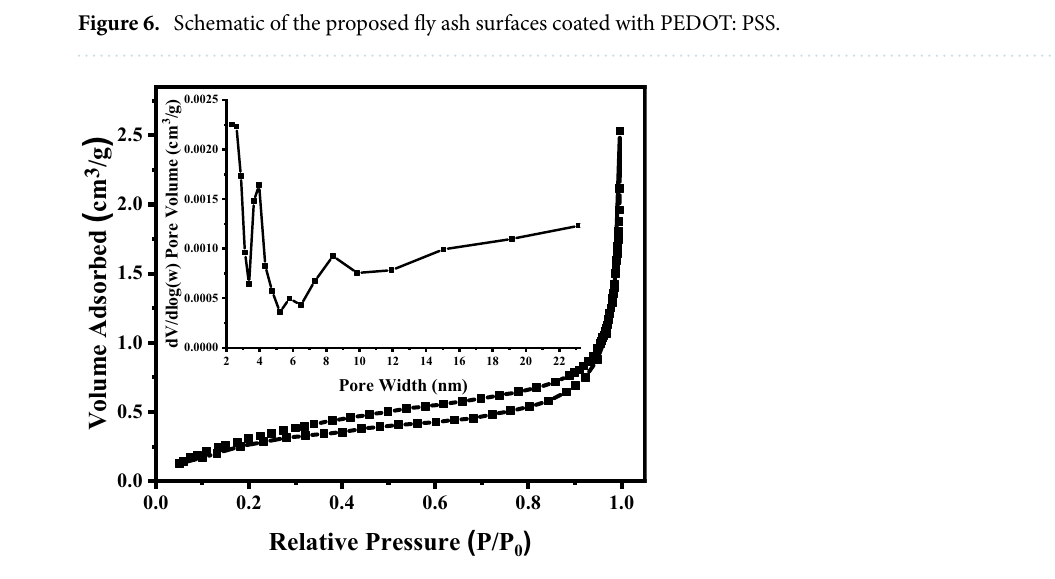
Figure 7. BET curves and pore size distribution (figure inset) of fly